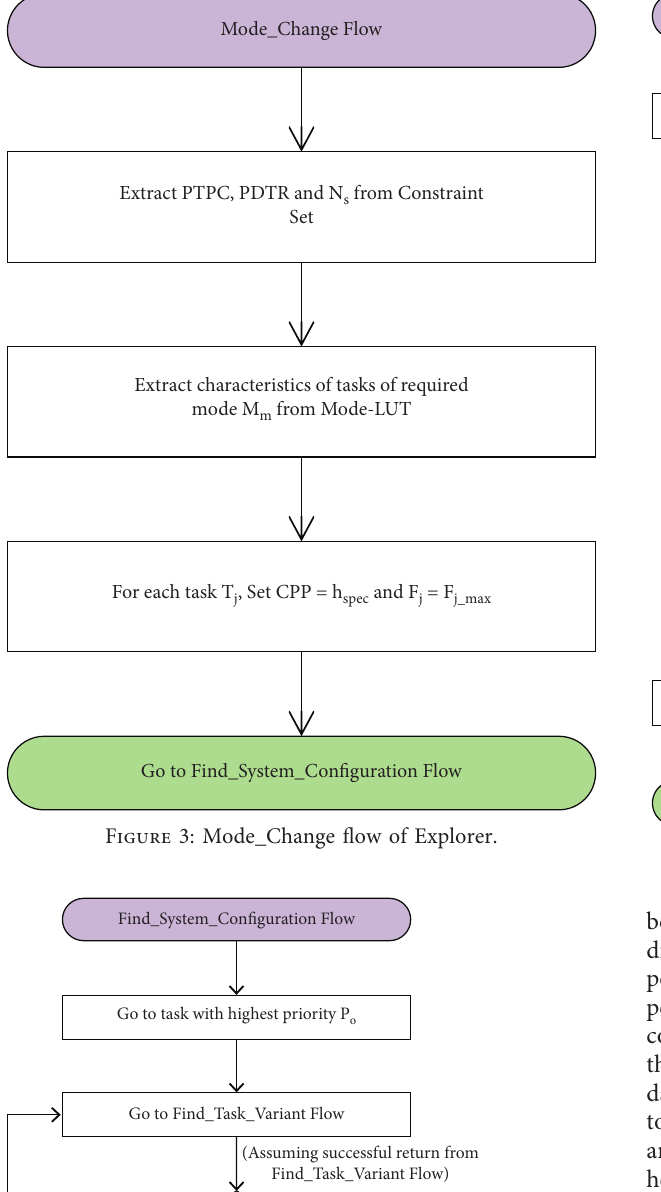
Figure 4: Find_System_Configuration flow of Explorer.